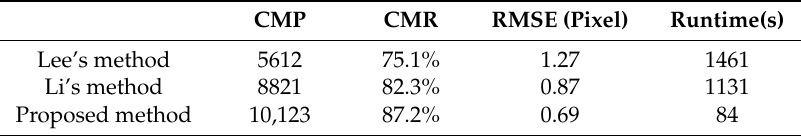
Table 3. Comparison of the three HR registration method on dataset 2.